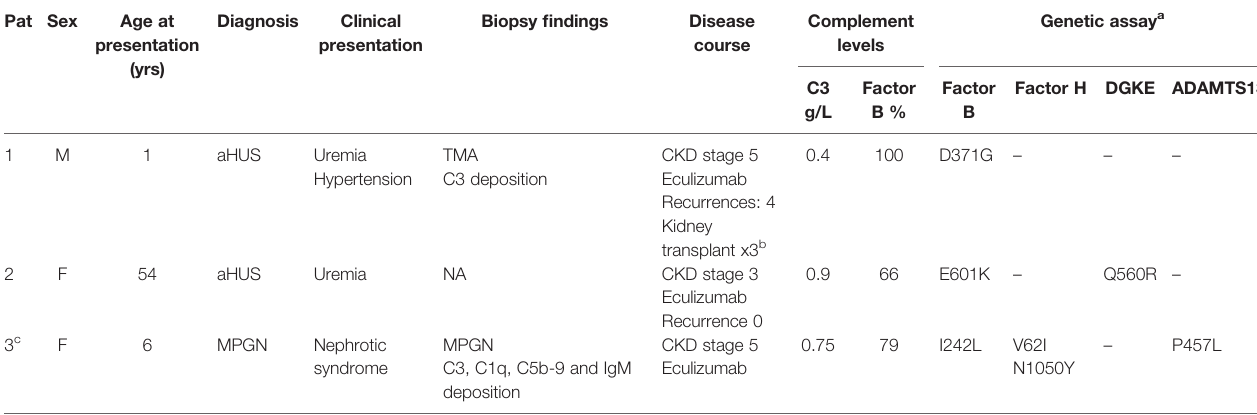
TABLE 1 | Clinical characteristics of patients included in this